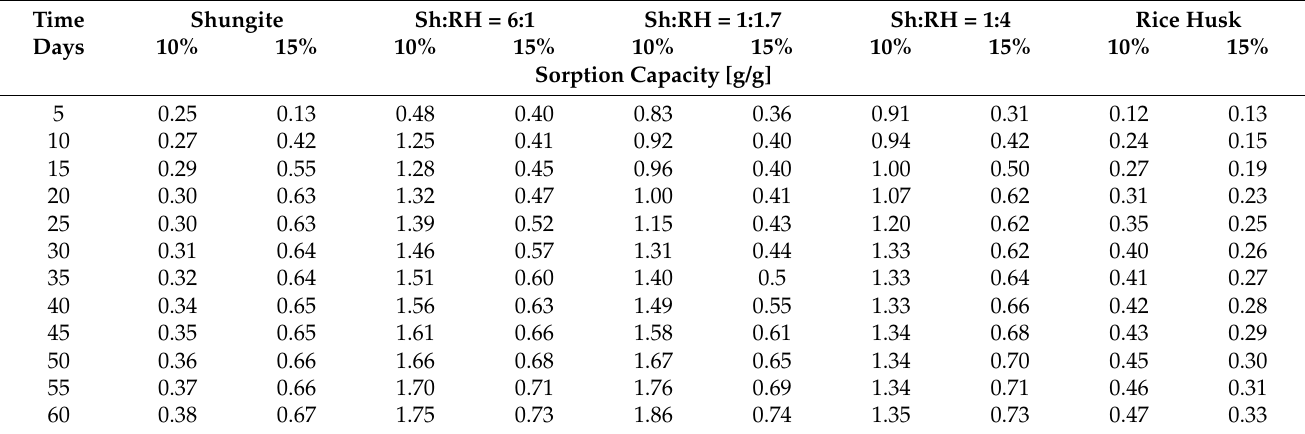
Table 1. Results of the sorption of oil from soil samples with oil contamination of 10% and 15% by sorbents based on shungite rocks.